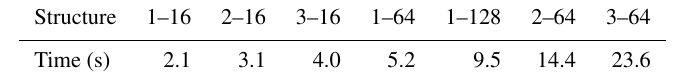
Table 3. Approximate time required to process 1 million data points using the different ANN structures investigated in this study. The number to the left of the hyphen is the number of hidden layers and the number to the right the number of hidden neurons per hidden layer.